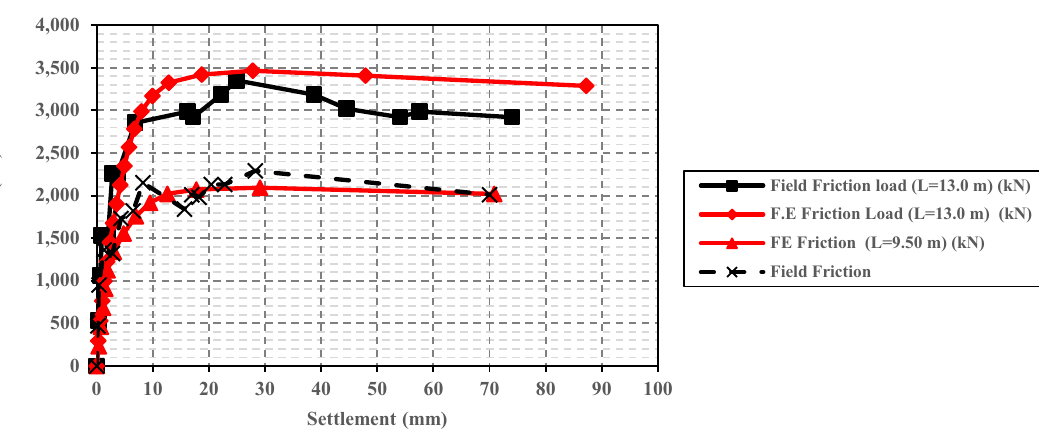
Figure 13. The relation between the obtained average unit skin friction and settlement for the four numerical models with different